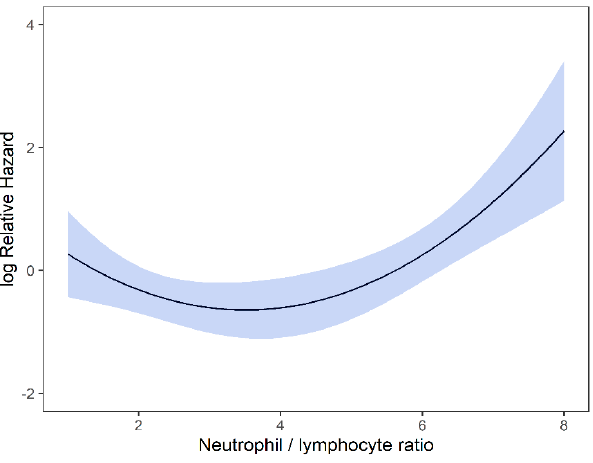
Figure 4. Risk of RFS by NLR.